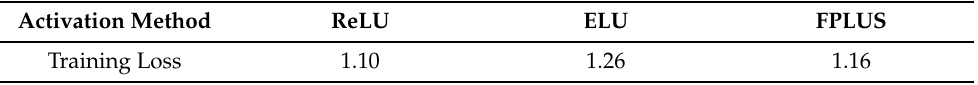
Table 8. Training loss of each activation method applied on ResNet-101 for